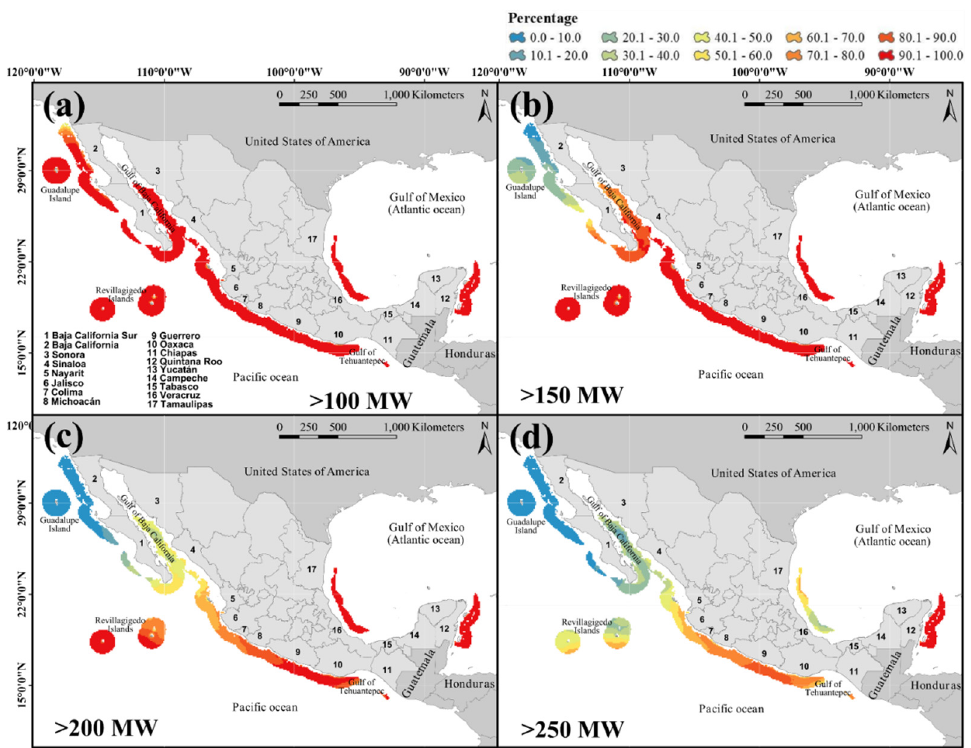
Figure 3. Theoretical results of thermal gradient power availability in Mexico (in percentages) for the five-year period considered (September 2013–August 2018). Results indicate the percentage of days (through the five-year period) when the available power was higher than the established thresholds. ( a ) Threshold of 100 MW. ( b ) Threshold of 150 MW. ( c ) Threshold of 200 MW. ( d ) Threshold of 250 MW. Table 1. Maximum power availability (in percentage of days over the ten-year period considered) for the energy from waves, currents, and thermal gradients.